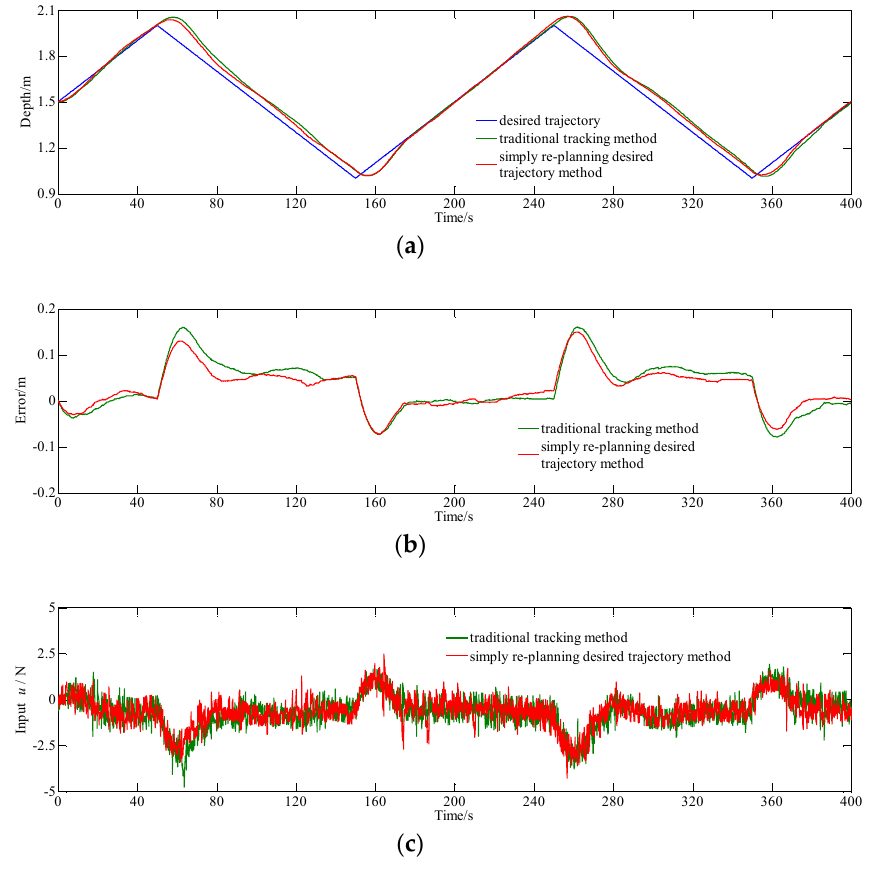
Figure 11. Comparative experiment results for simply re-planning the desired trajectory method and conventional tracking method with MPC tracking triangular trajectory. ( a ) depth data; ( b ) eError data; and ( c ) input u. Table 4. Statistical Results of Figure 11.